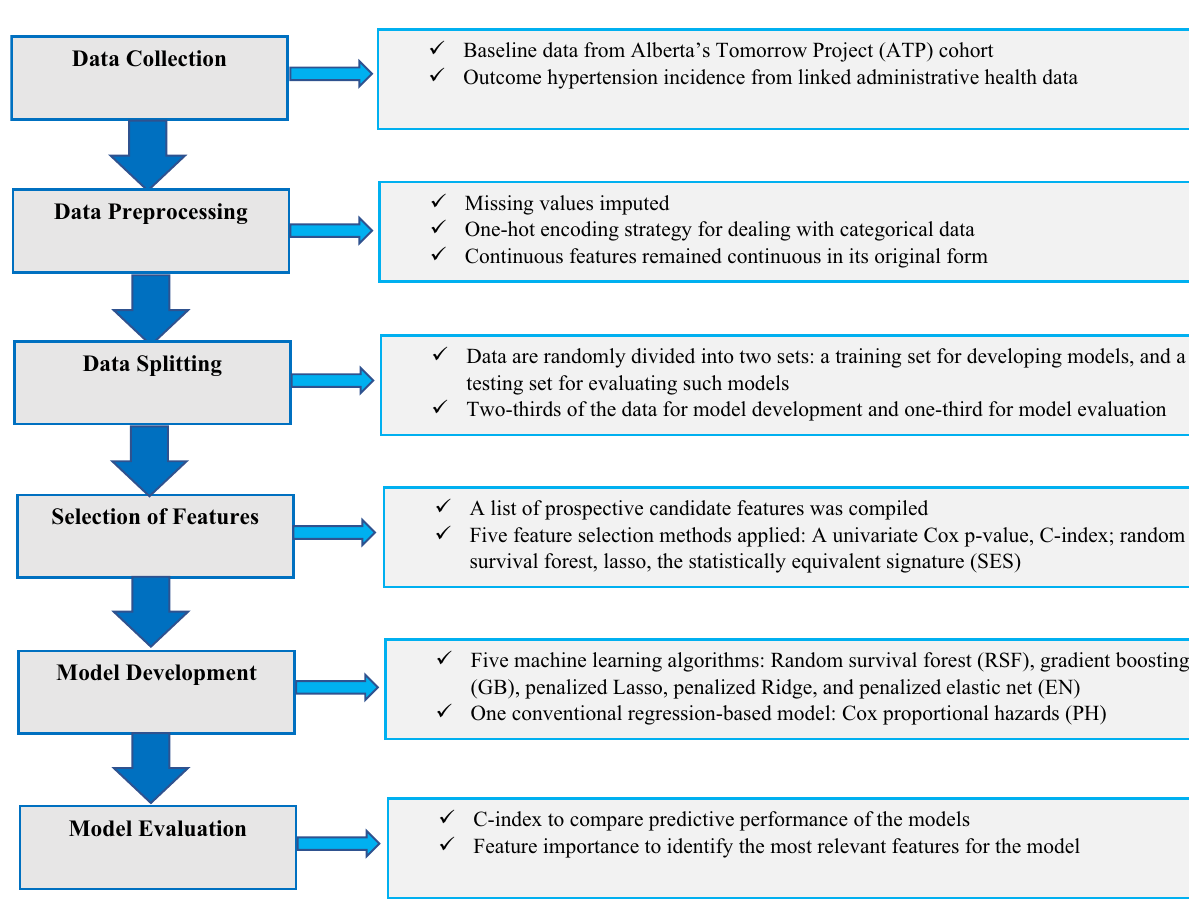
Figure 1. Graphical illustration of the workflow used for this